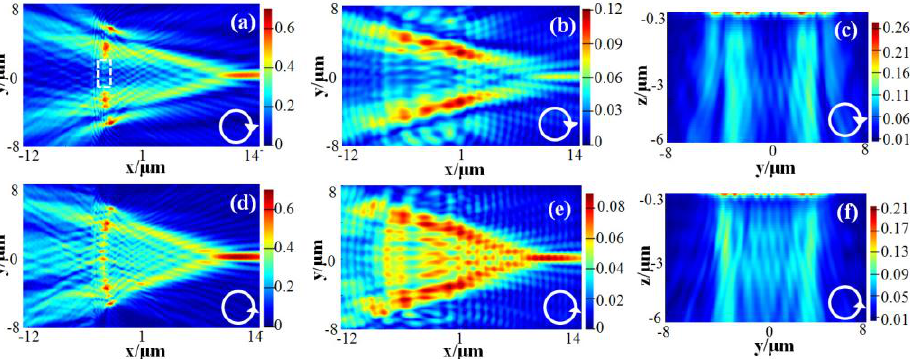
Figure 2. The simulated results of the ( a ) near field at z o = − 200 nm and ( b ) far field at z o = − 6 µ m electric field light intensity distributions generated by the sensor for the case of right − hand CPL incidence. The simulated results of the ( d ) near field at z o = − 200 nm and ( e ) far field at z o = − 6 µ m electric field light intensity distributions for the case of of left − hand CPL incidence. ( c , f ) show the electric field light intensity distribution at y − z plane (i.e., x = 0 μm, −6 μm ≤ z ≤ −0.3 μm) of the cases of ( a , b ) and ( d , e ), respectively. The amplitude of the incident light is set to 1.